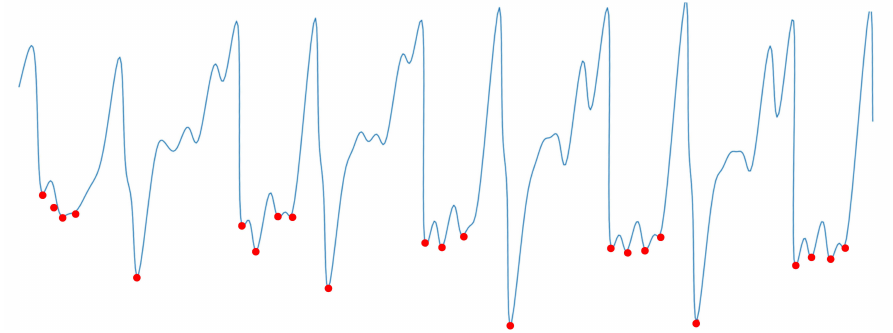
Figure 6. Minimal value after initial